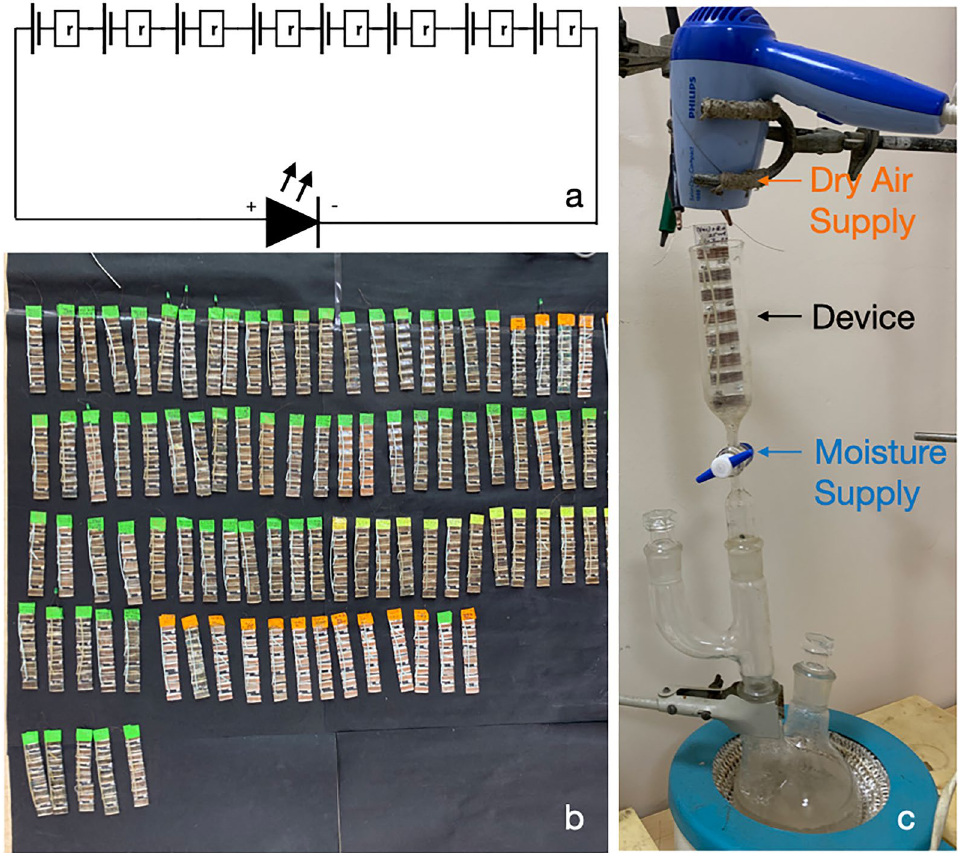
Figure 2. Procedure for making silk cocoon biobattery. ( a ) Eight silk electrochemical cells connected in a series circuit. ( b ) The array of silk cocoon bio-battery. ( c ) Boiling water from the round bottom flask supplies water vapor. The temperature at the surface of the device is around 55–60°. ( d ) A hairdryer blows dry air to evaporate the water from the device. The devices get 2 min of water vapor exposure in all the